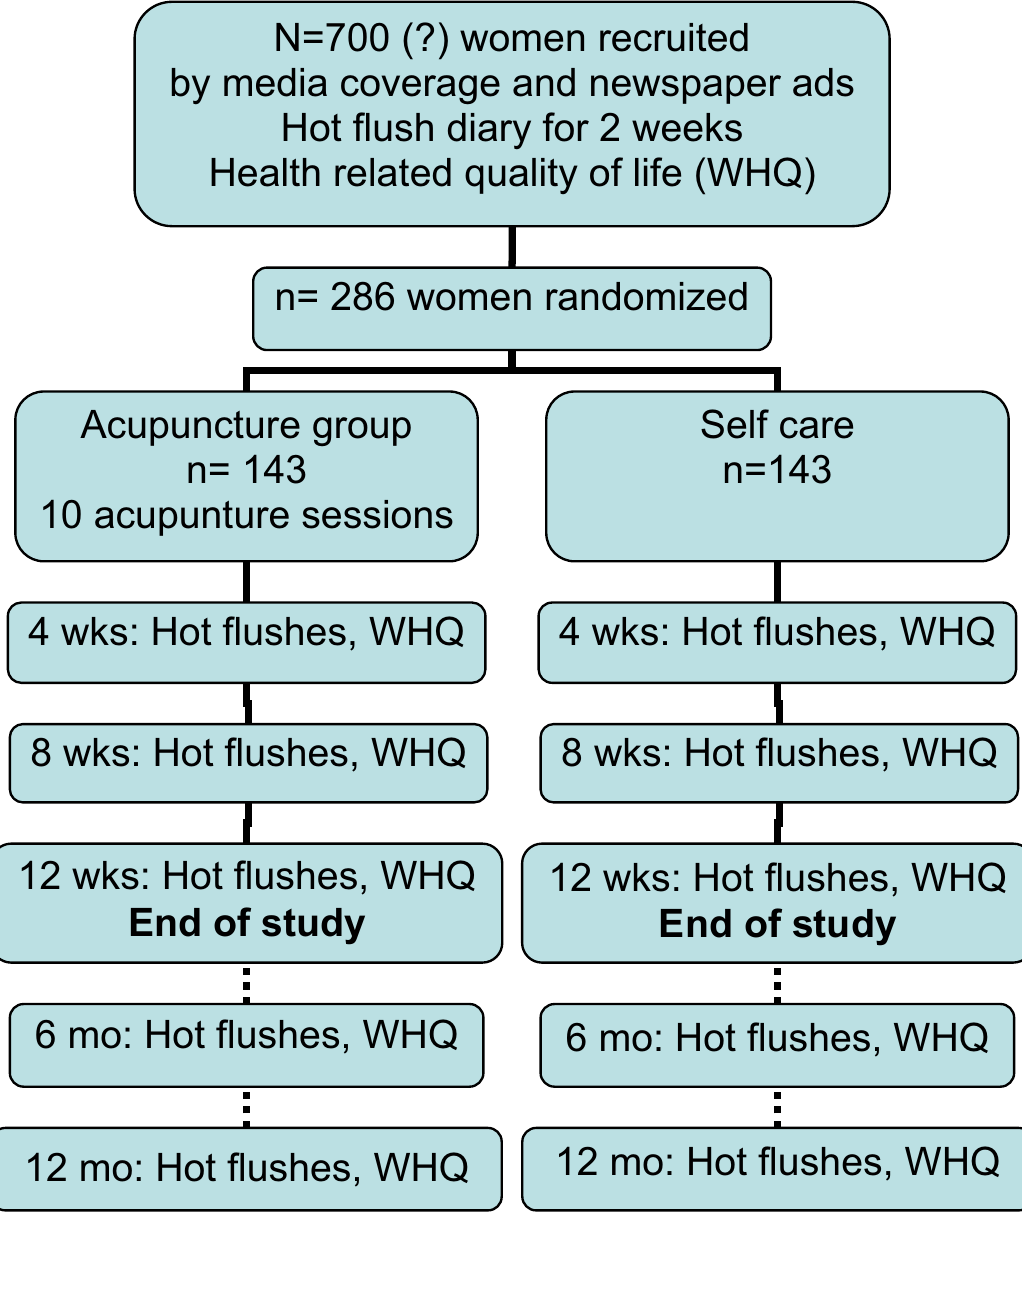
Flow diagram of study design Figure 1